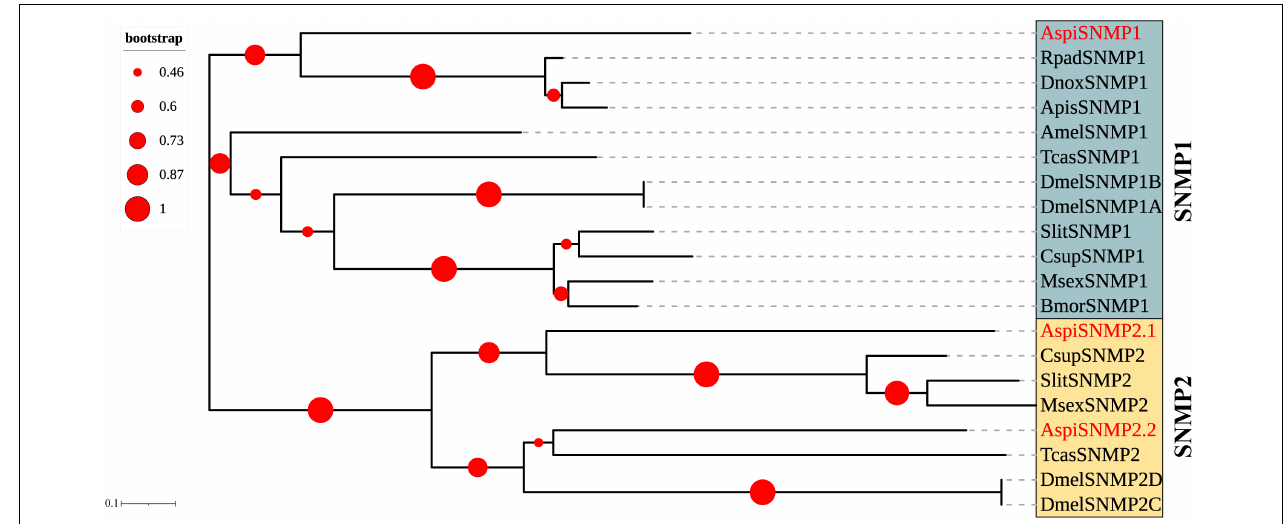
FIGURE 4 | Phylogenetic analysis of putative sensory neuron membrane proteins of A. spiniferus .